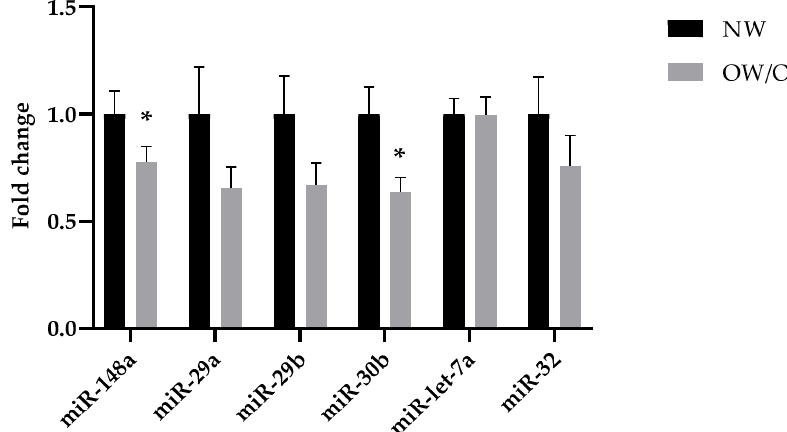
Figure 1. Levels of miRNA-148a and 30b are reduced in milk of overweight (OW)/obese (OB) mothers at 1 month of lactation mean ± Standard Error of Mean ( SEM ). * = p < 0.05. Fold change of miR-148a ( p = 0.04) and miR-30b ( p = 0.007) was lower in OW/OB mothers than in normal-weight (NW) mothers.